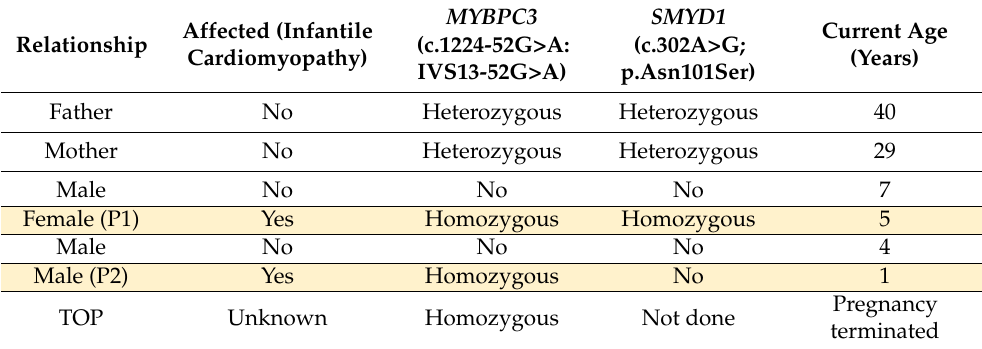
Table 1. Whole exome sequencing/familial genetic testing results from the proband’s family showing variants in MYBPC3 and SMYD1